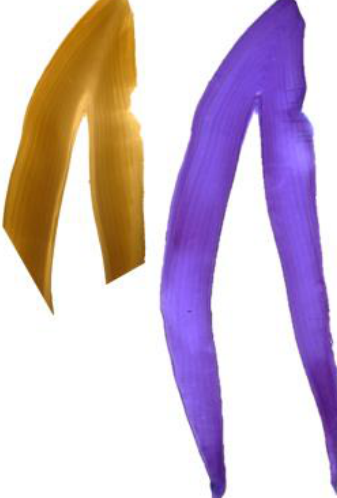
Fig. 5. A comparison of GLG clarity from an acid etched (left) and stained, decalcified section (right) of a killer whale ( Orcinus orca ) aged 9